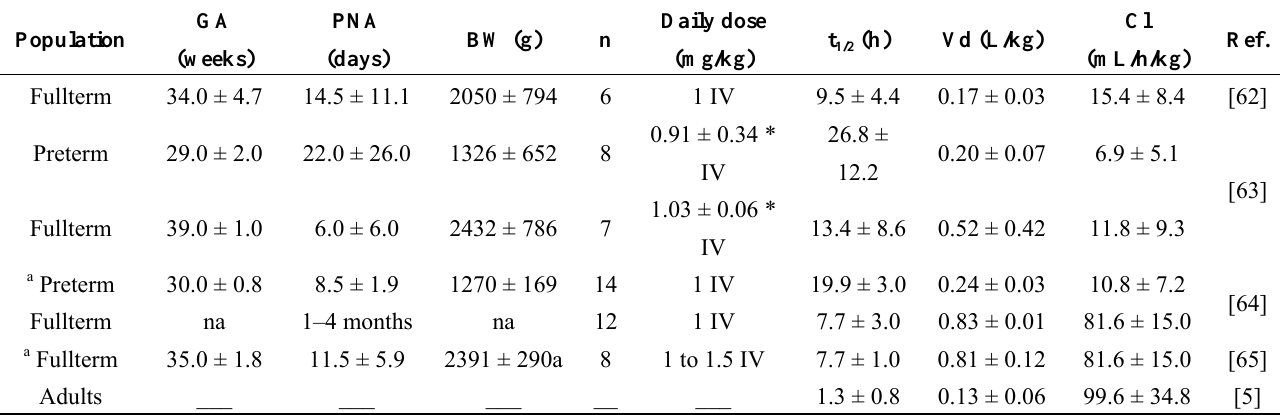
Table 2. Demographic data of infants and pharmacokinetic parameters of furosemide in